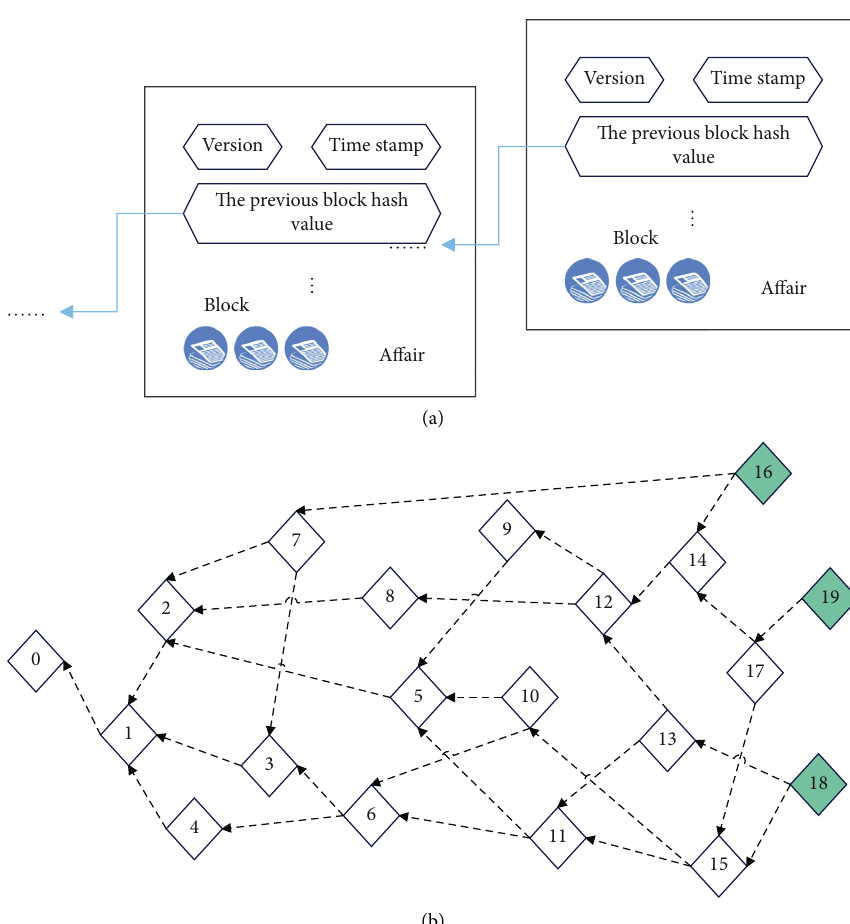
Figure 6: Blockchain data structure. (a) Chained structure blockchain. (b) Directed acyclic graph structure